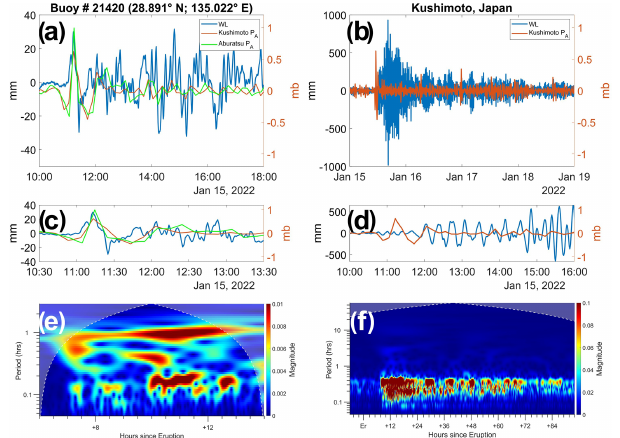
Figure 4. Comparison of WL (blue, mm) and P A (orange, mb) at offshore buoy 51407 and Hilo, HI. (a) P A at NOAA tide gauge 1617760 Hilo, HI, and detided WL residual from NOAA P B buoy 51407 south of Hawai’i following the Tonga event; (b) P A and de- tided residual WL (blue) at Hilo; (c) expanded view of (a) showing the arrival of the VMT at buoy 51407 in the form of a supercrit- ical forced wave at 08:54UTC ahead of the marine tsunami wave arrival at ∼ 10:54UTC (c) ; (d) expanded view of (b) showing the arrival at Hilo of the VMT in the form of a subcritical free wave at 09:28UTC; (e) a CWT scalogram of buoy heights from P B for 6–24h after the eruption; (f) a CWT scalogram of WL measured at Hilo for 92h after the